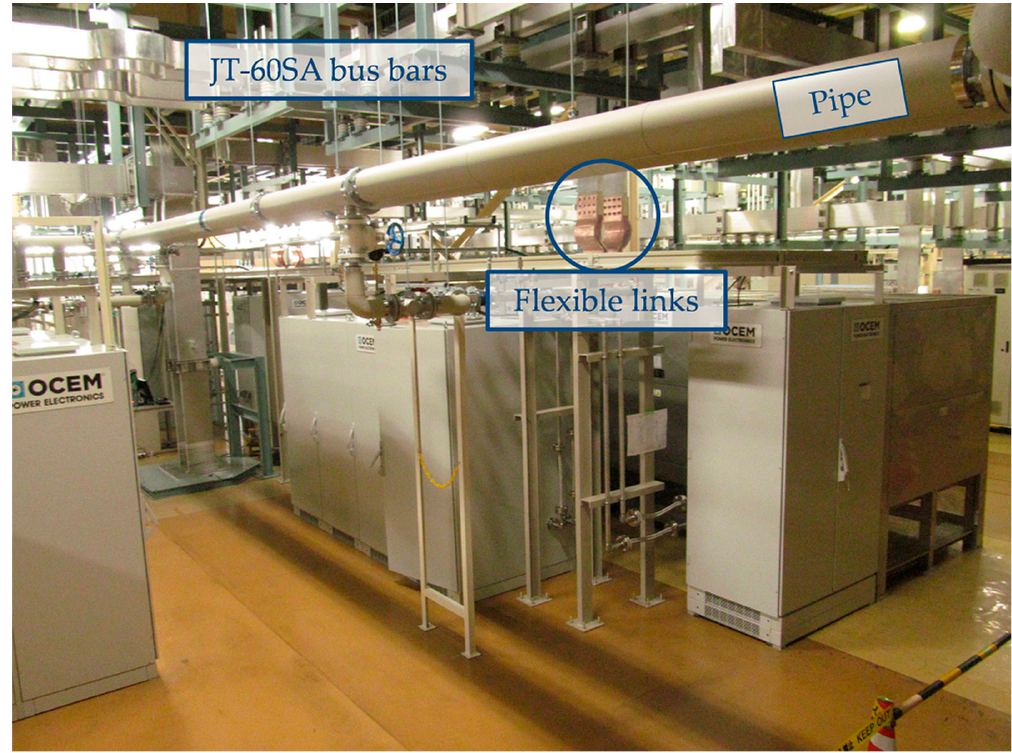
Figure 6. SNUs after installation and connection to the DC bus bars of JT-60SA CS and to the JT-60SA services and external systems (demineralized cooling water, auxiliary PS, communication interfaces, interlocks and so on). The flexible links connect each SNU to the DC bus bars. The labeled pipe provides the demineralized water to the SNUs.